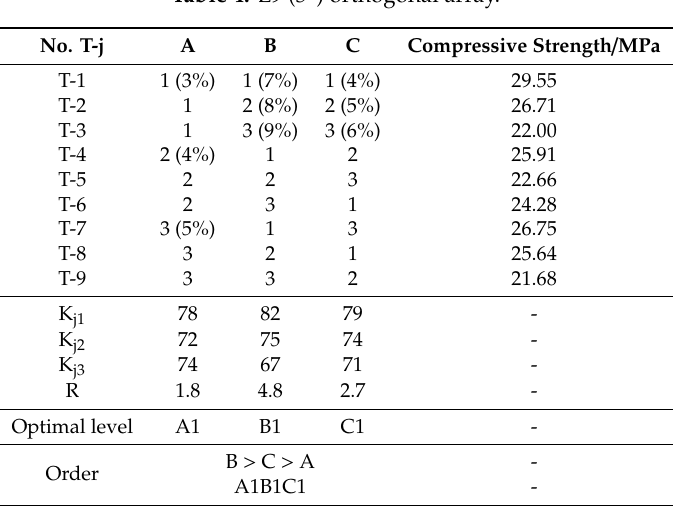
Table 4. L9 (3 3 ) orthogonal